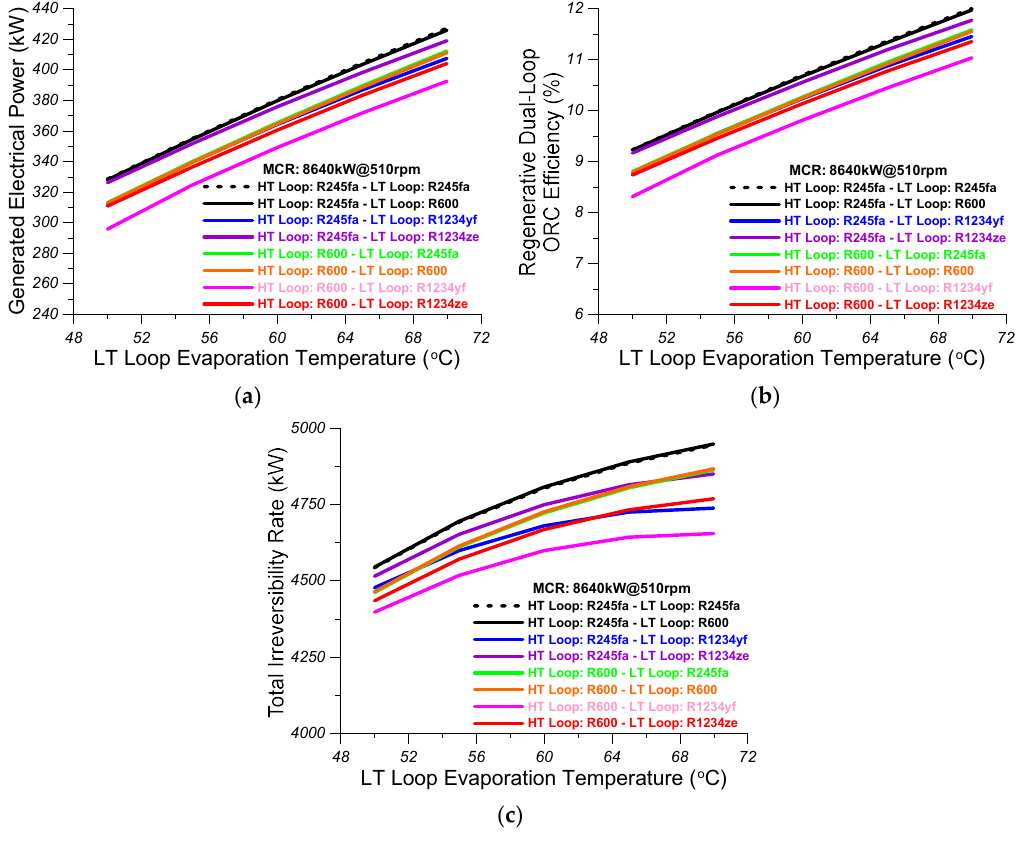
Figure 13. (a) Effect of the evaporation temperature of the LT loop on the generated electric power of the regenerative dual-loop ORC; (b) Effect of the evaporation temperature of the LT loop on the thermal efficiency of the regenerative dual-loop ORC; (c) Effect of the evaporation temperature of the LT loop on the total irreversibility rate of the regenerative dual-loop ORC. Results are given for all the pairs of organic mediums that are examined in the present study.